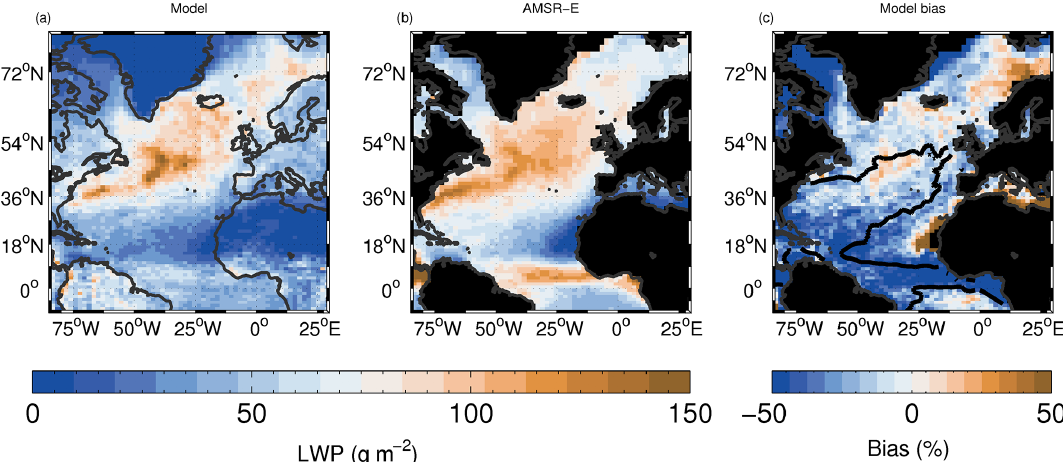
Figure D1. Time-mean all-sky (i.e. including cloudy and clear regions) LWP model evaluation for both day and night overpasses. Panel (c) includes a contour of the 0.9 value of f LWP ; see Fig. 4 for the full map of f LWP for reference.